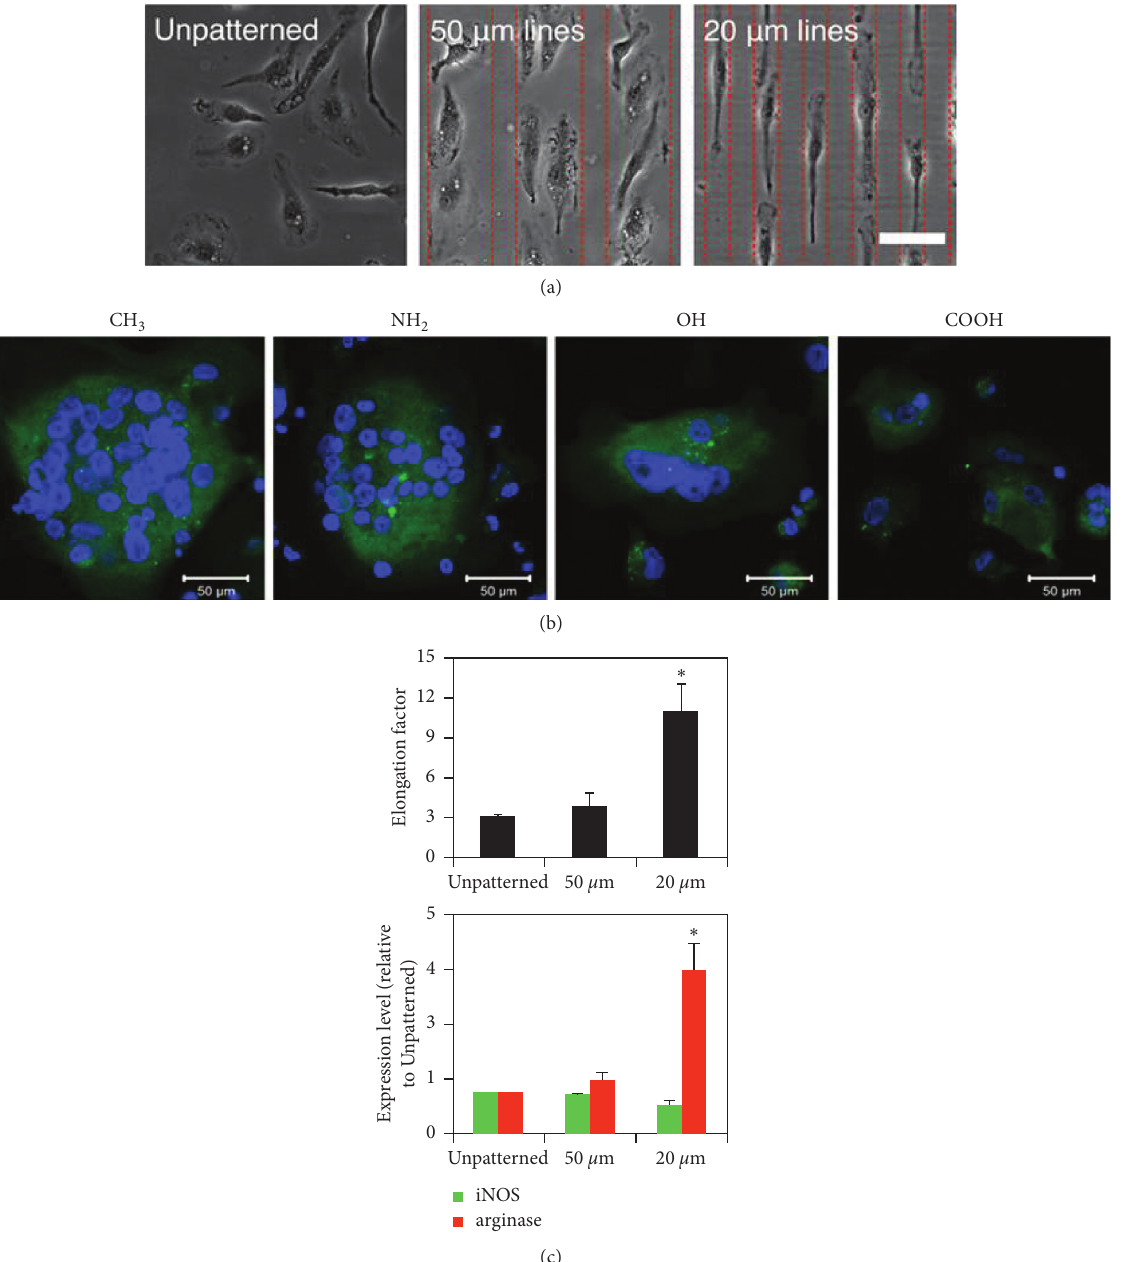
Figure 3: (a) The elongation of cells by micropatterning drives macrophage polarization [121] (Copyright 2013, National Academy of Sciences). (b) Expression of β 1 integrin was determined by fusing macrophages/FBGCs in macrophage monocultures at CH 3 , NH 2 , OH, and COOH surfaces [122] (Copyright 2015,